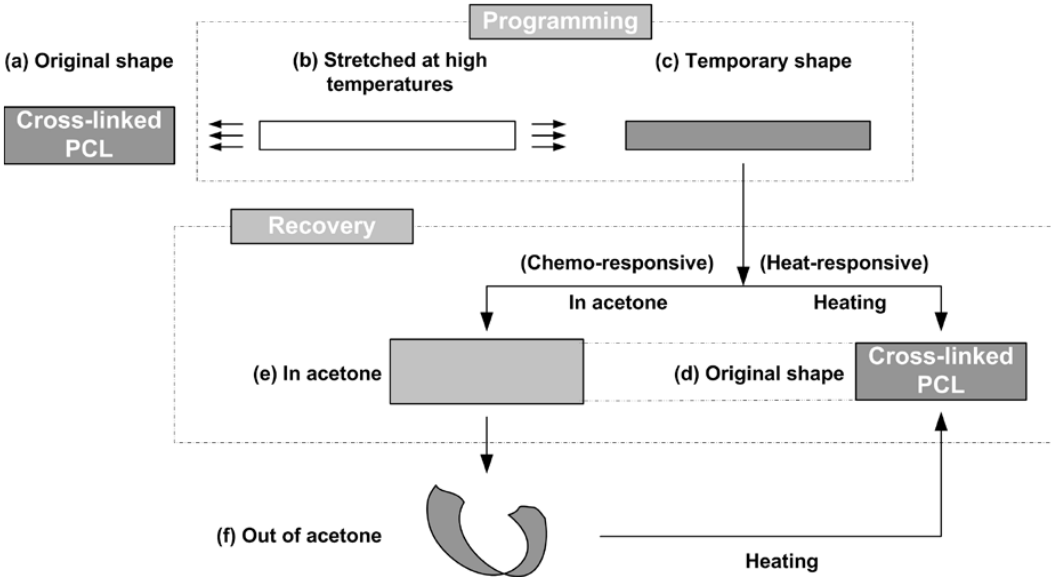
Figure 1. Shape memory effect in thermoset polycaprolactone (PCL). ( a ) Original strip shaped sample;